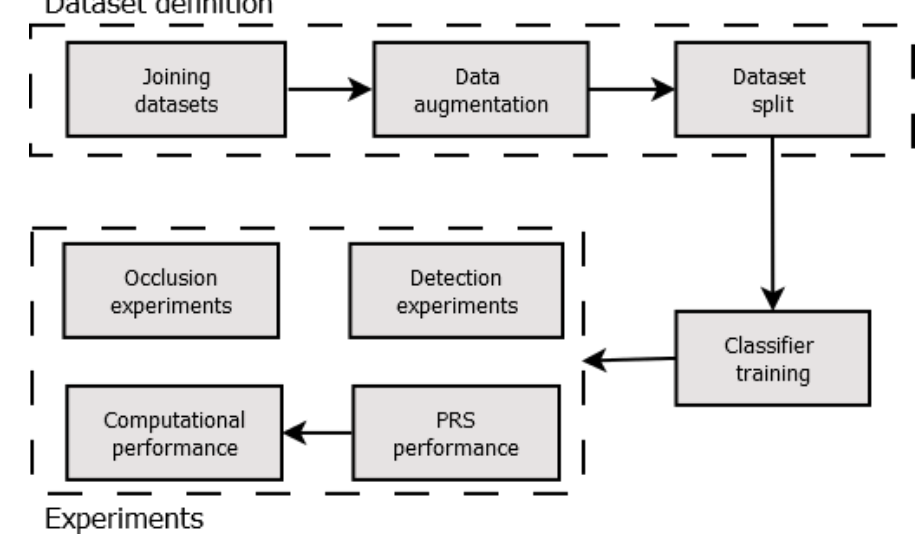
Figure 3. Overview of the research